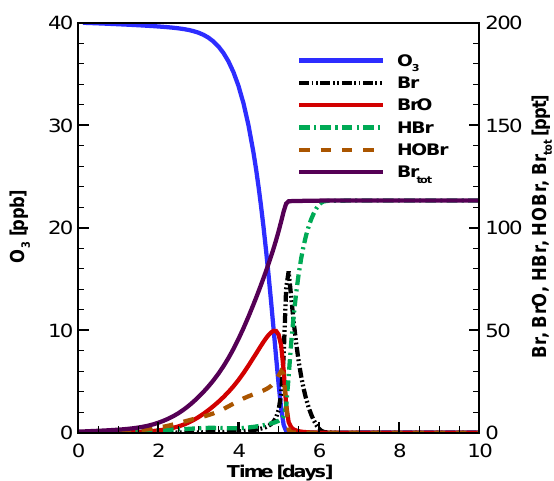
Figure 1. The development of the mixing ratios of ozone and principal bromine species with time in a 200m boundary layer.